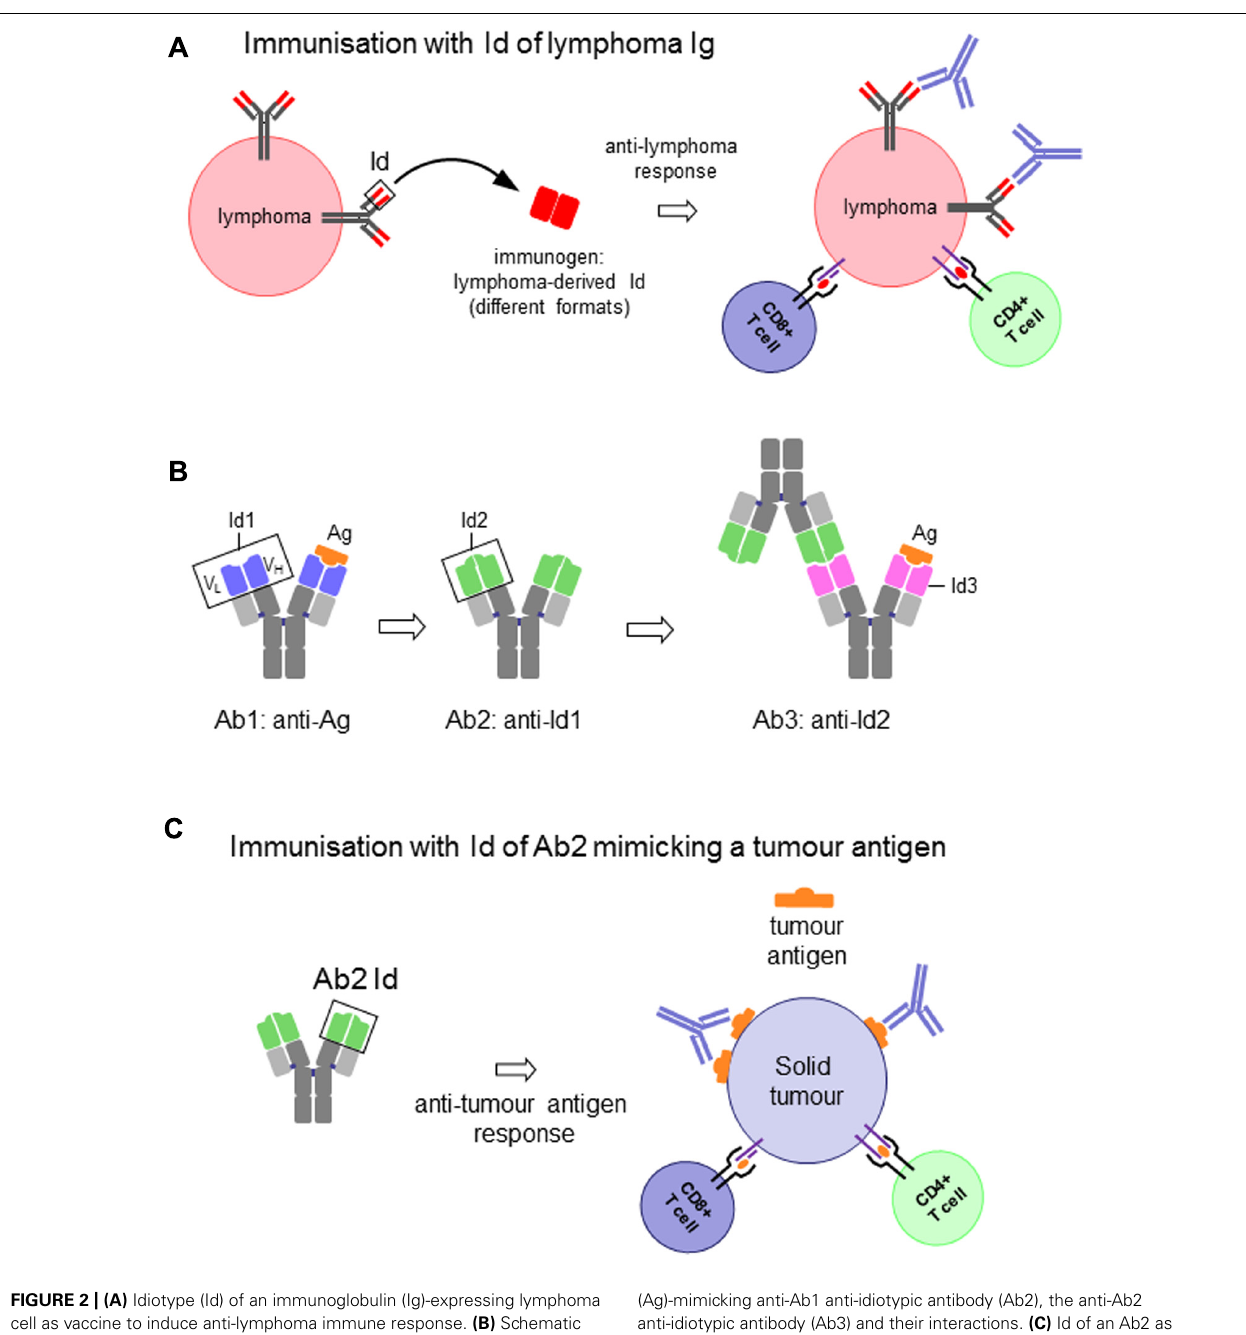
FIGURE 2 | (A) Idiotype (Id) of an immunoglobulin (Ig)-expressing lymphoma cell as vaccine to induce anti-lymphoma immune response. (B) Schematic representation of the antigen-specific antibody (Ab1), the antigen